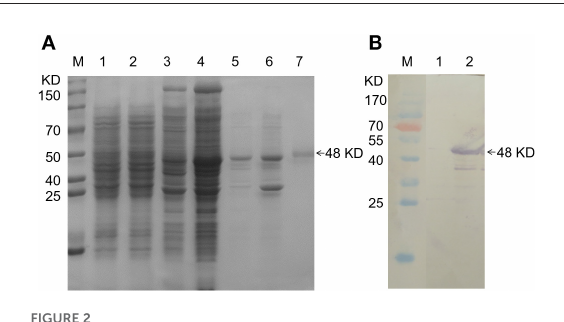
FIGURE2 Expression and purification of pGEX-4T-1/TFG (194) protein. (A) SDS-PAGE analysis of the recombinant TFG (194) protein. M: Protein molecular weight Marker; lane 1, lane 3: Expression product of pGEX-4T-1 and pGEX-4T-1/TFG (194) before induction, respectively; lane 2, lane 4: Expression product of pGEX-4T-1 and pGEX-4T-1/TFG (194) of after induction, respectively; lane 5: Supernatant of expression product of recombinant TFG (194) protein after IPTG induction; lane 6: Precipitation of expression product of recombinant TFG (194) protein after IPTG induction; lane 7: Purified TFG (194) protein. (B) Western blot analysis of recombinant TFG (194) protein. M: Protein molecular weight Marker; lane 1: Reaction of anti-GST antibody with the bacteria lysate of pGEX-4T-1/TFG (194) before induction; lane 2: Reaction of anti-GST antibody with the purified fusion protein.